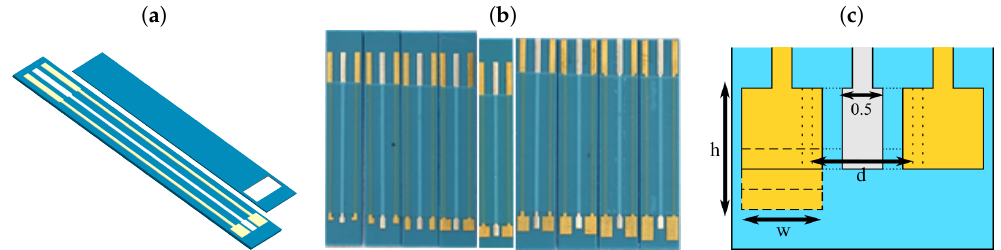
( a ) Design of integrated electrochemical cell fabricated using LTCC technology; ( b ) Photograph of all types of integrated electrochemical cell fabricated using LTCC technology; ( c ) Schematic drawing presenting the integrated electrochemical cell dimensions. Table 1. Dimensions of the integrated electrochemical sensors and calculated values of R ct for c Fe 2 + /3 + = 1.17 mmol and cell constant, where h —height of WE and CE, w —width of WE and CE, d dm 3